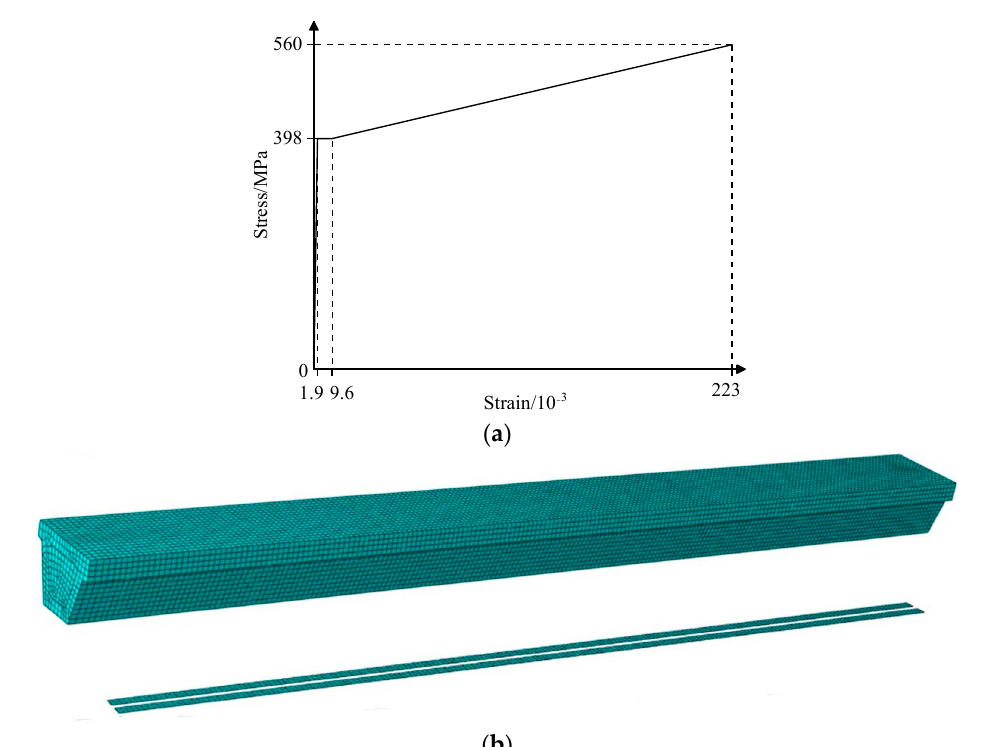
Figure 11. Re fi ned model of the repaired #3-2 girder strengthened by steel plates. ( a ) Stress vs. strain curve of steel plates; ( b ) Re fi ned model.